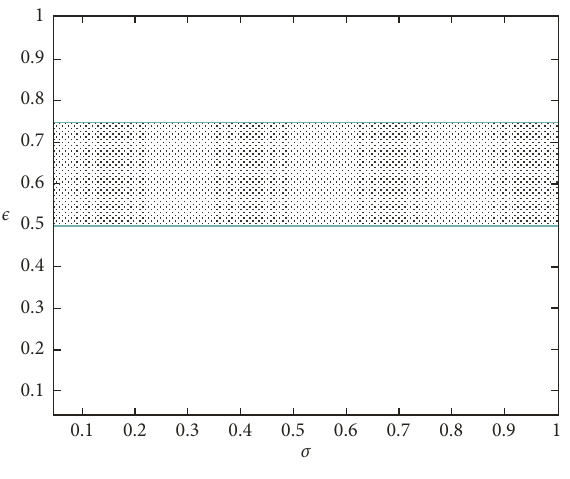
Figure 4: ε and σ value